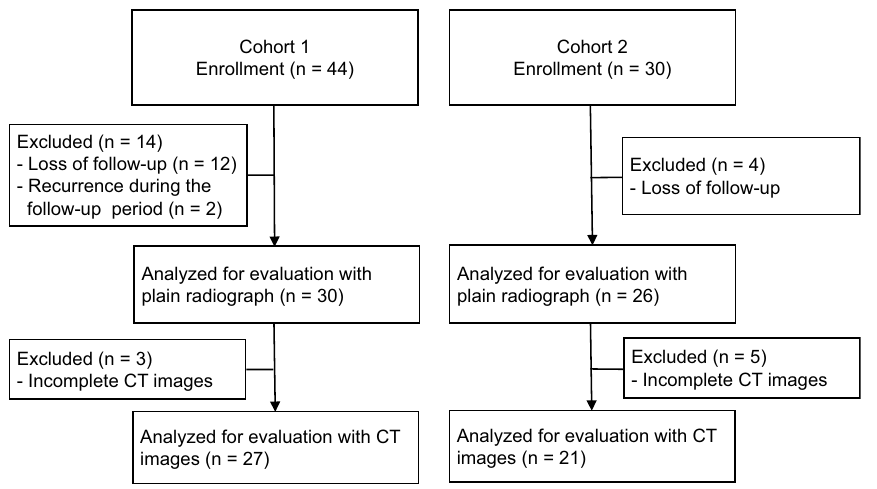
Figure 1. Flowchart of the study patients. CT computed